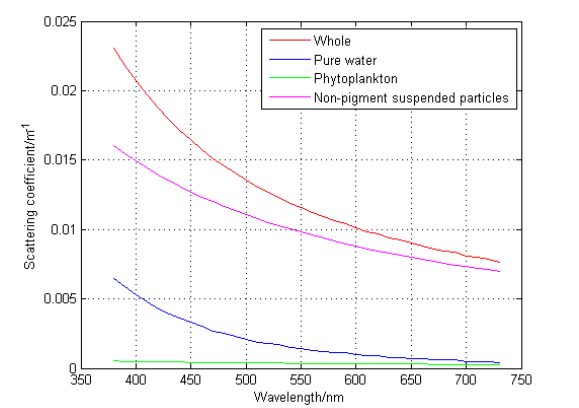
Figure 2. Scattering spectra of